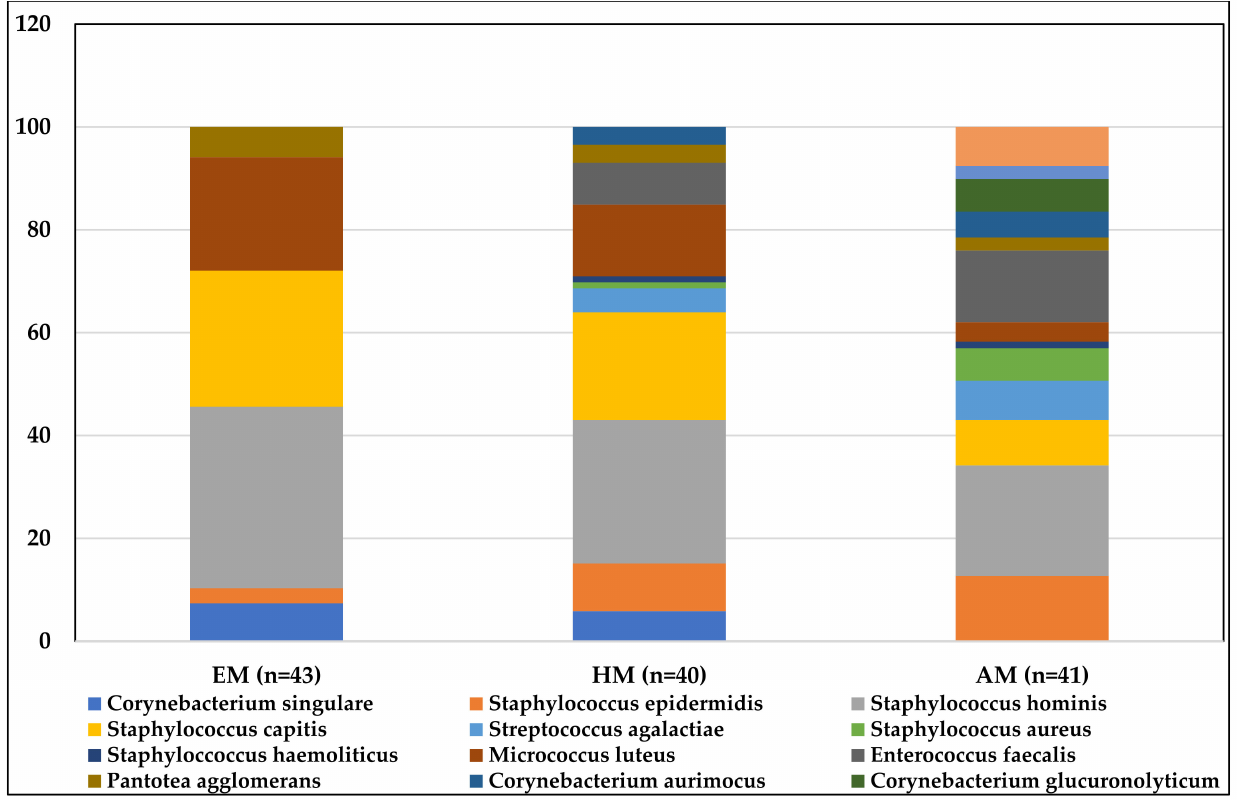
Figure 2. Graphical representation of bacterial species identified in the studied groups and their preva- lence. EM—excellent motility group, GM—good motility group, AM—acceptable motility group.